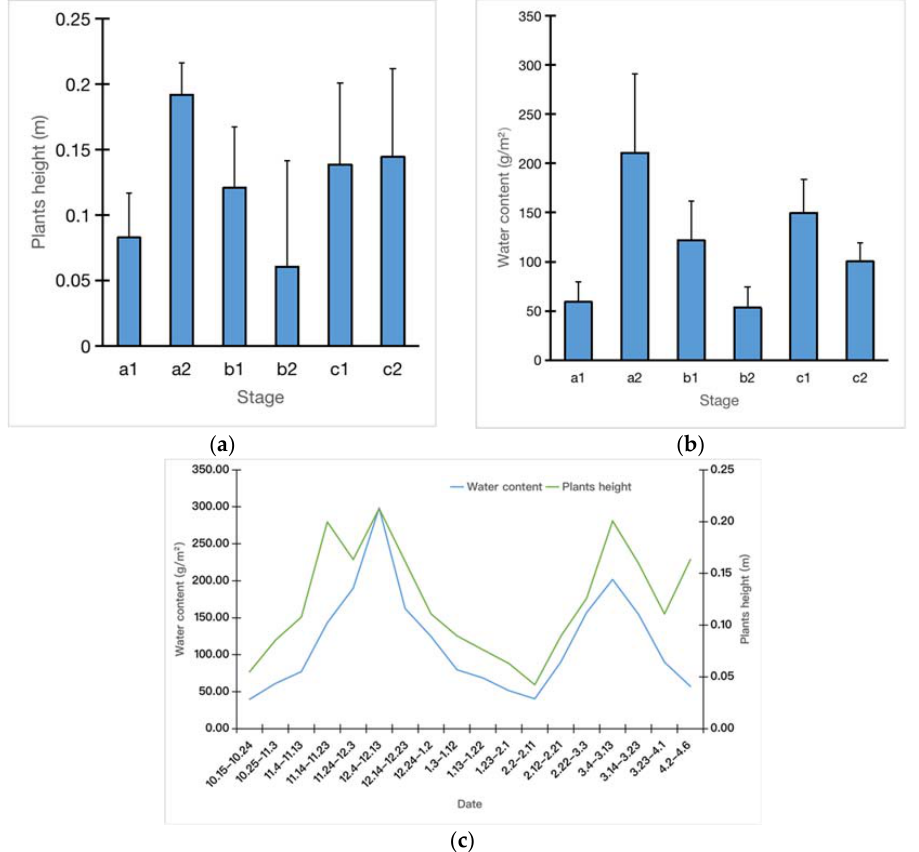
Figure 2. Dynamic changes in the plant height and water content of sedges at Shengjin Lake. ( a ) Changes in the height ( b ) and in the water content. ( c ) The dynamic changes in plant height and water content showed a bimodal distribution trend during the whole winter. (a1 and a2—Early Winter, b1 and b2—Middle Winter, c1 and c2—Late Winter).